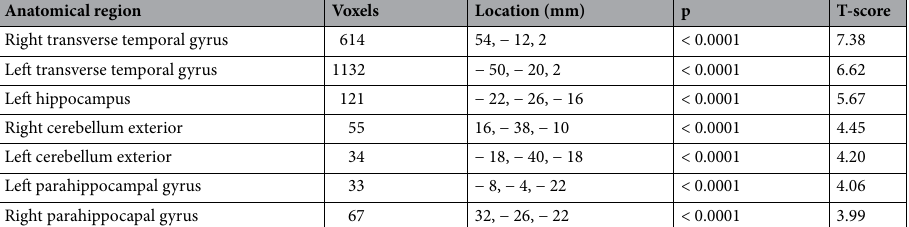
Table 1. Local maxima of brain regions with significantly different levels of BOLD activity between music and no music trials (voxel size: 2 × 2 × 2 mm). Locations are reported in the Montreal Neurological Institute (MNI) coordinate